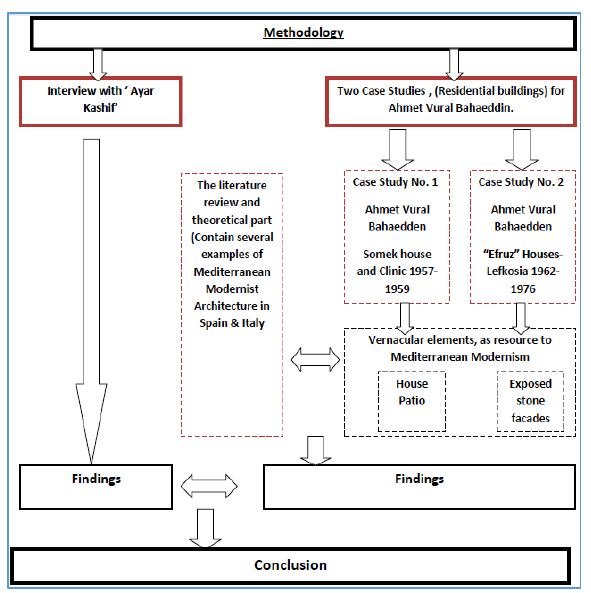
Figure 13. Methodology Framework (Developed by